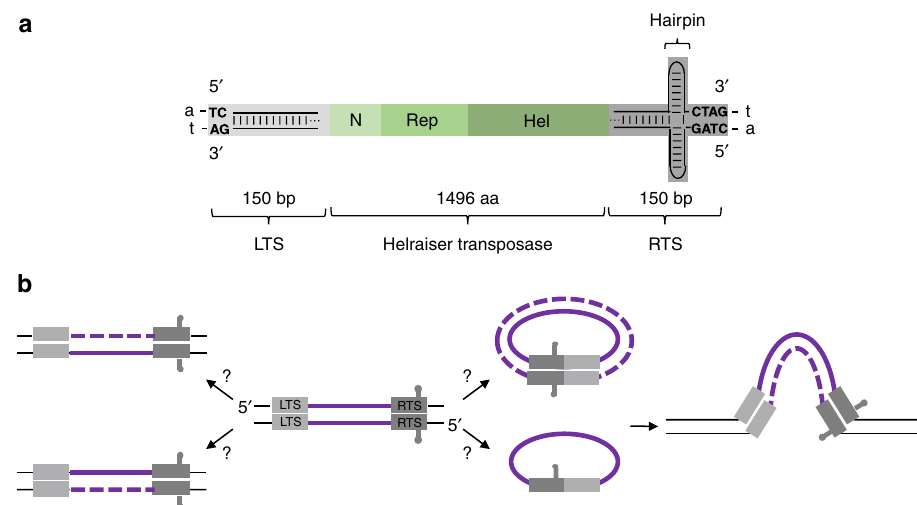
Fig. 1 Features of Helraiser transposon and overview of transposition pathway. a Schematic representation of Helraiser transposon. The 150-bp left terminal sequence (LTS) is shown in light gray, and the 150-bp right terminal sequence (RTS) in dark gray, with the location of a potential hairpin indicated. N- terminal, Rep and helicase domains of the Helraiser transposase are shown as green rectangles. Conserved di- and tetranucleotide terminal sequence motifs are in uppercase. Flanking host A-T dinucleotide is in lowercase. b Schematic model and open questions of Helitron transposition. The transposase is proposed to excise one of the transposon strands from the double-stranded donor molecule (shown in the middle). Transposon excision is most likely followed by DNA synthesis that regenerates the transposon donor site (shown on the left). The excised transposon strand forms a single or double- stranded transposon circle that is possibly integrated into the target site in the host genome (shown on the right). LTS is shown in light gray and the RTS in dark gray. Solid purple lines: transposon donor strands; black lines: genomic sequence; and dashed lines: synthesized transposon